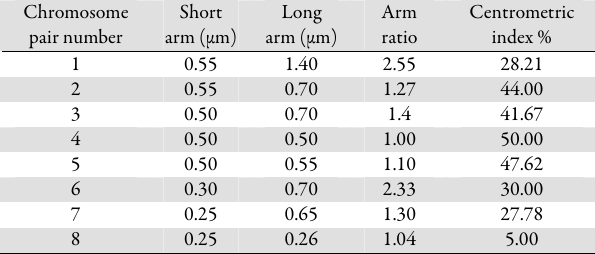
Tab. 1. Karyotypic data on Monodora